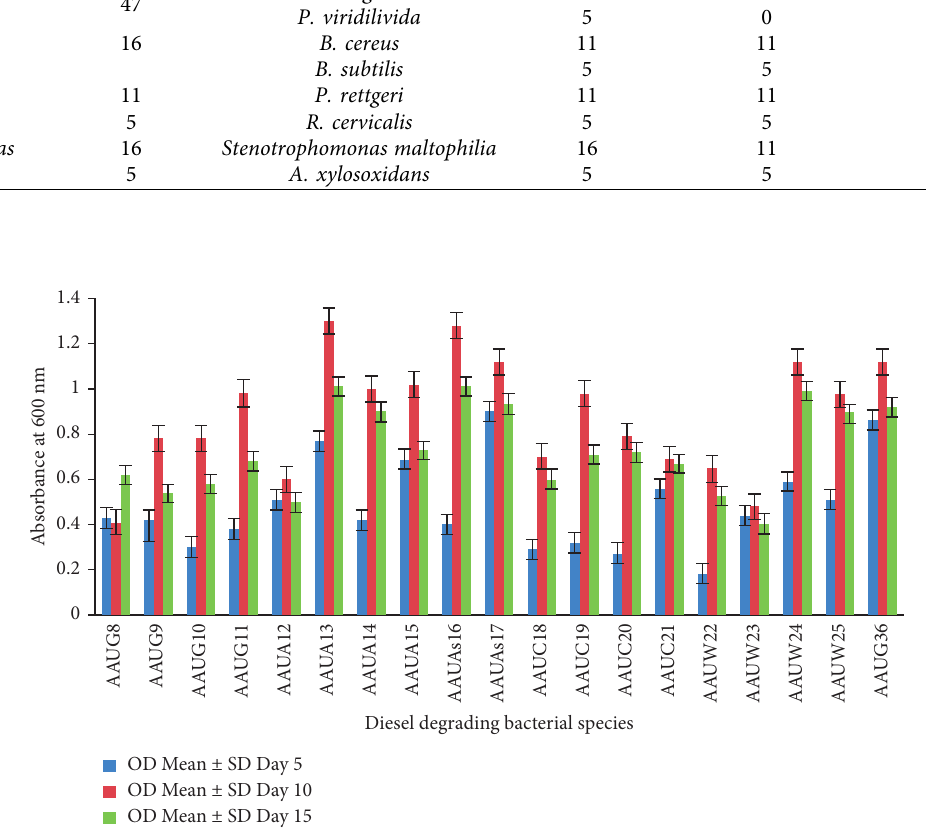
Figure 1: Growth capacity of isolates on diesel (1% concentration at different growth